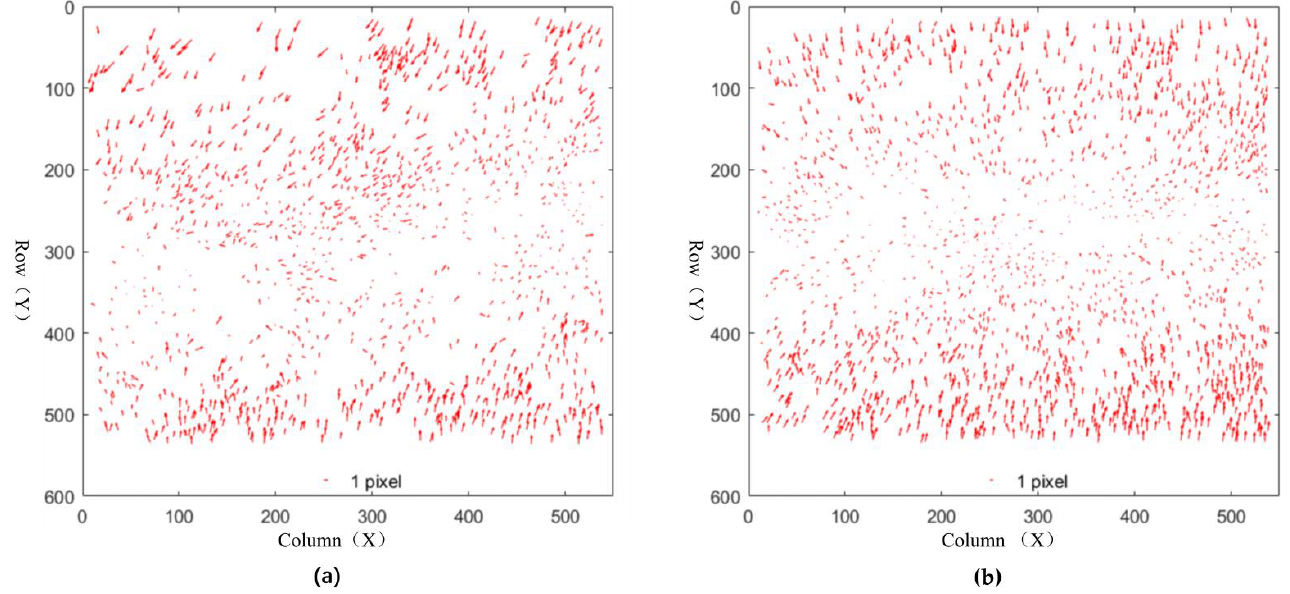
Figure 3. Referencing digital orthophoto map and laser footprint images in calibration area.